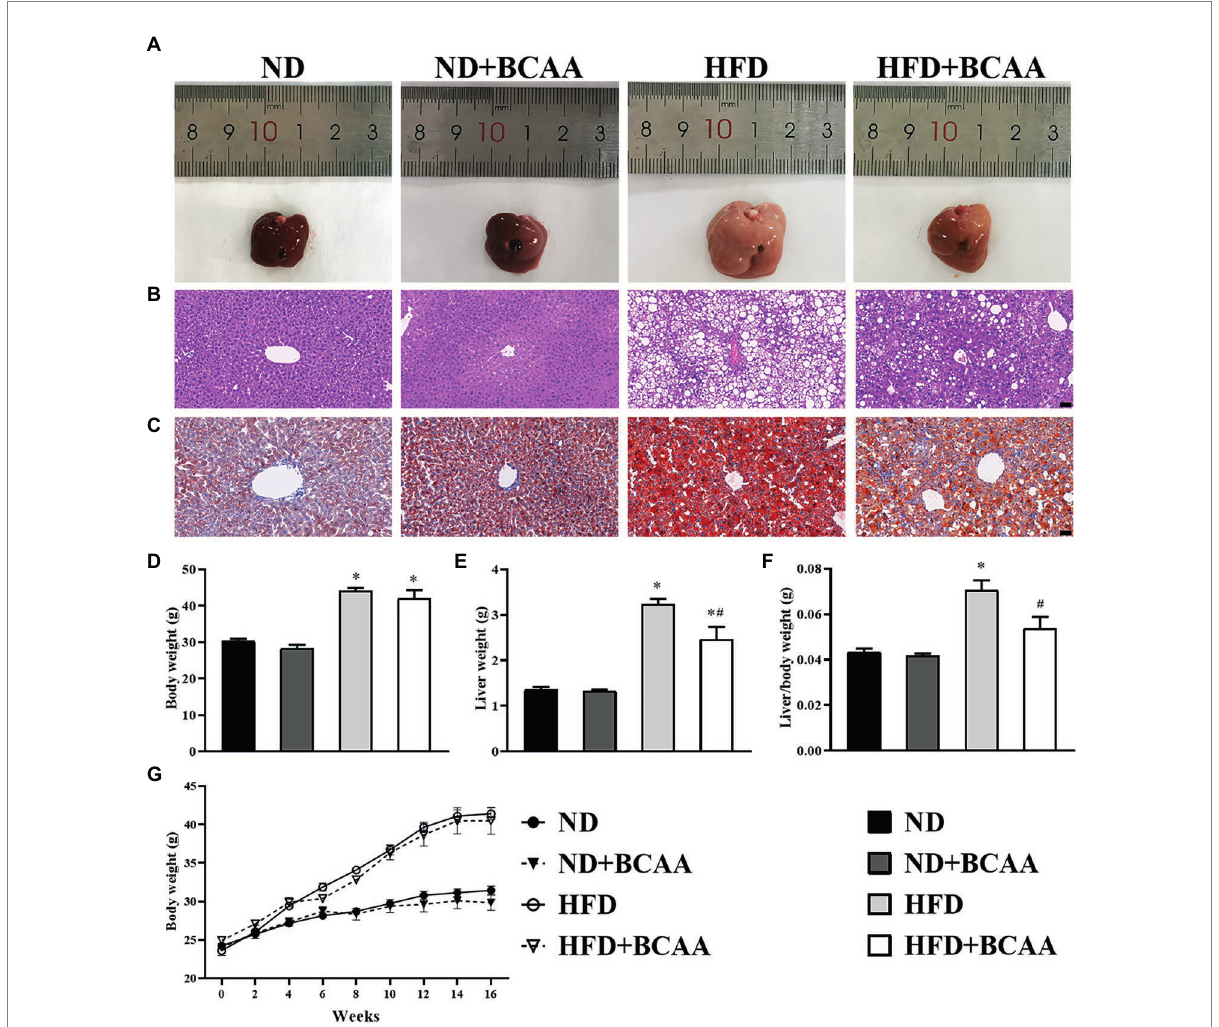
FIGURE 2 Effect of BCAAs supplementation on the hepatic lipid accumulation in mice. (A) Macroscopic view of livers from the different groups. Representative images of the light microscopic (B) HE and (C) oil red O staining of liver tissues from the different groups, bar = 50 μ m. (D,G) Body weights ( n = 9 for the ND, ND + BCAAs and HFD groups, n = 10 for the ND + BCAAs group), (E) liver weights ( n = 4), and (F) liver/body weight ratios ( n = 4). The data are presented as the mean ± SEM. * p < 0.05 vs. the ND group; # p < 0.05 vs. the HFD